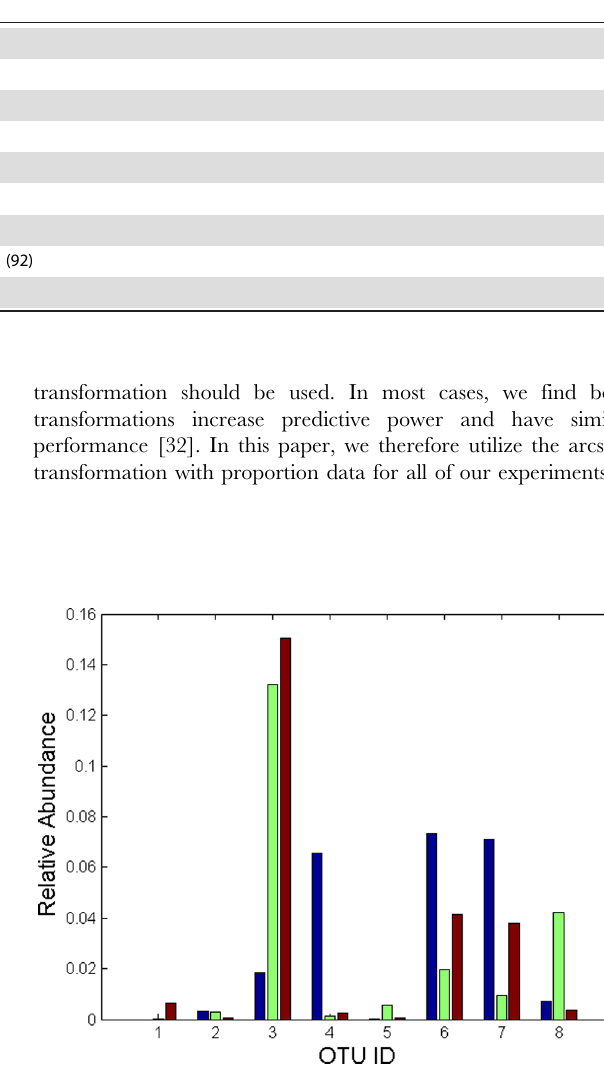
Figure 2. Relative abundances of the identified features for three healthy individuals: Left: Individual 1, Middle: 2, Right: 3.